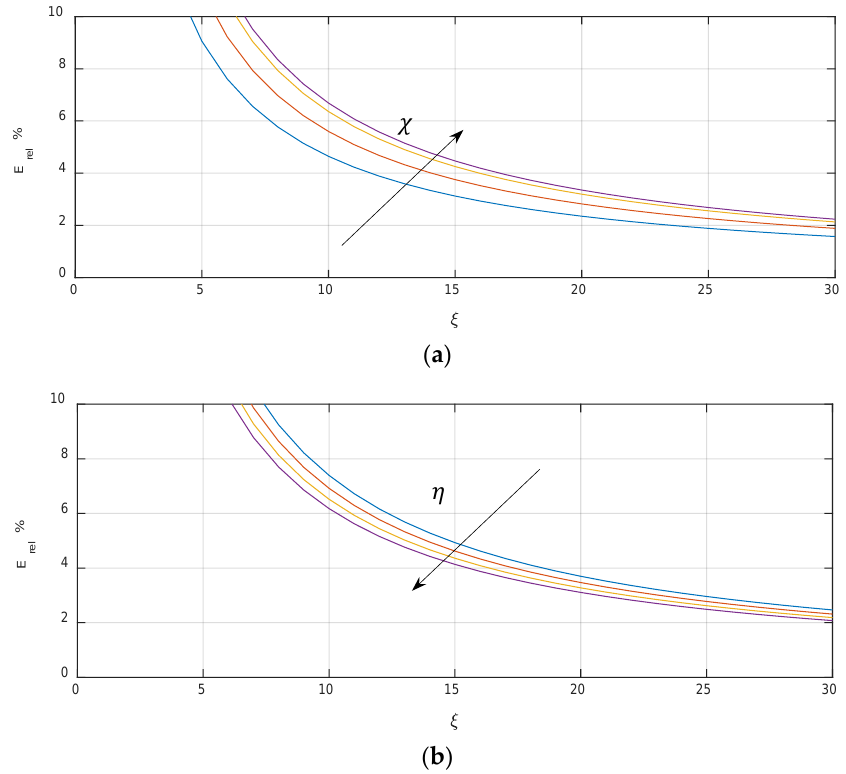
Figure 5. Energy gain of the OCBM with respect to the optimal Steady wind turbine, varying with χ in figure ( a ) and η in ( b ).